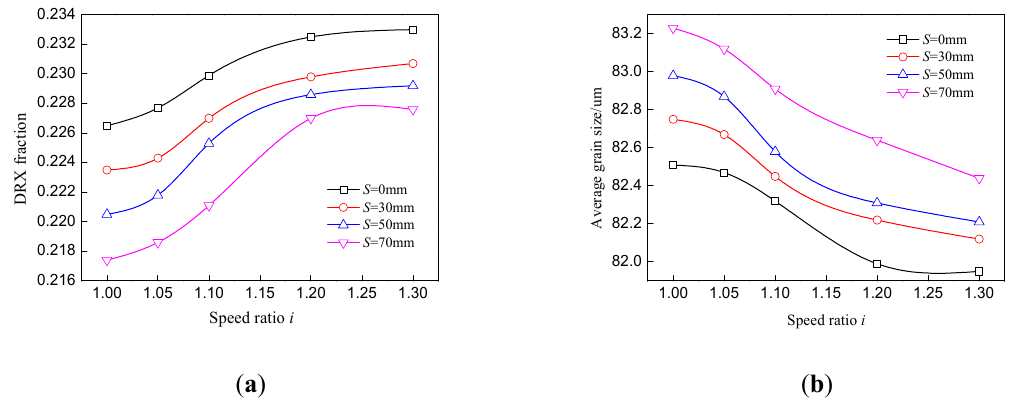
Figure 10. Effect of speed ratio on ( a ): Recrystallization fraction and ( b ): Average grain size at the center point of the plate.